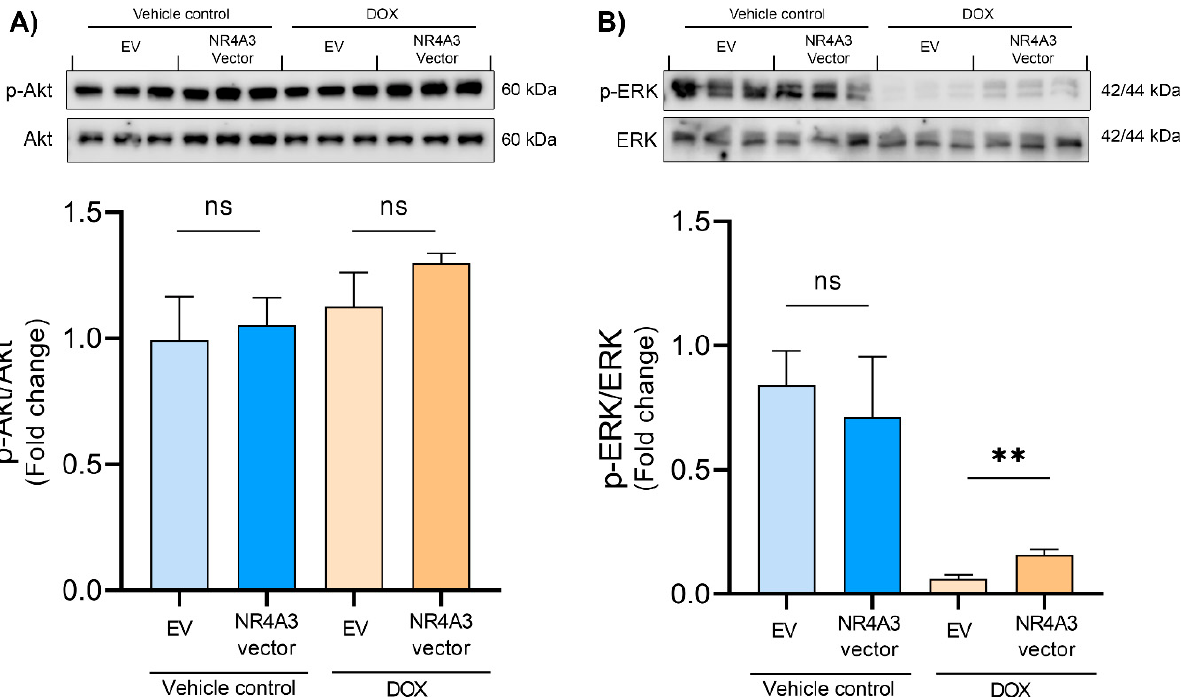
Figure 4. Phosphorylation of Akt and ERK measured by Western blotting. ( A ) Treating the CMs with DOX for 12 h showed no effect on phosphorylation of Akt (Ser473) and neither did transfecting with NR4A3. ( B ) DOX treatment caused a great decrease in phosphorylation of ERK (Thr202/Tyr204). The decrease in phosphorylation was significantly attenuated by transfecting with NR4A3 before DOX treatment. The graphs in ( A , B ) are presented with mean ± SD ( N = 3). ns = p > 0.05 (not significant), ** = p ≤ 0.01 .